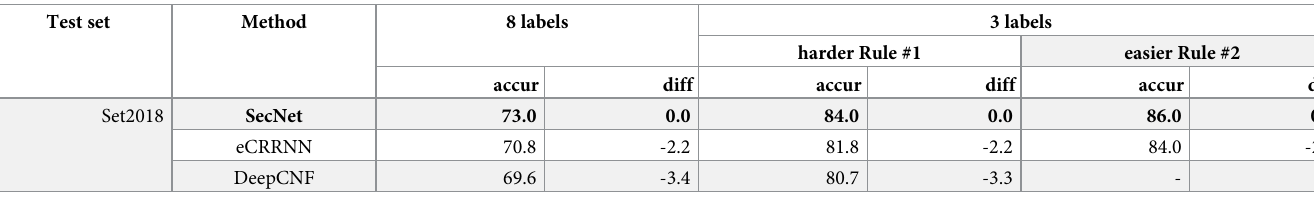
Table 6. Benchmarking of SecNet , DeepCNF , and eCRRNN on Test2018 . Test